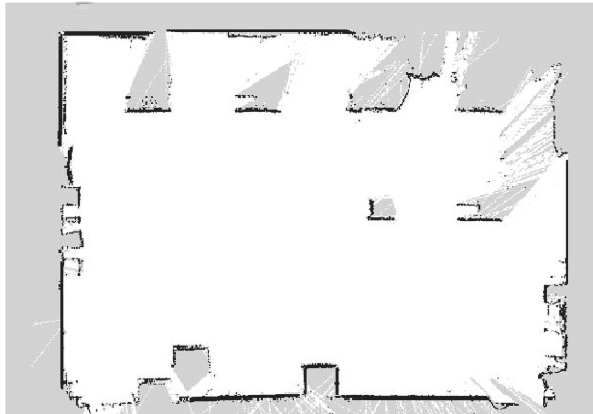
Figure 4: Two-dimensional scanning image of the test